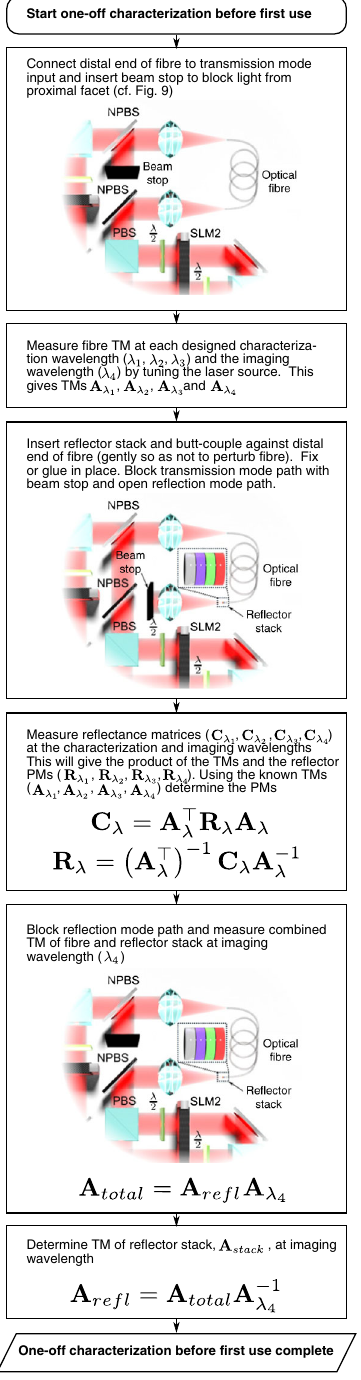
FIG. 11. Flowchart detailing the measurement process required to accurately characterize the reflector matrices of the reflector stack at different wavelengths prior to the first use of the system. This process is achieved using the experimental setup of Fig. 9.